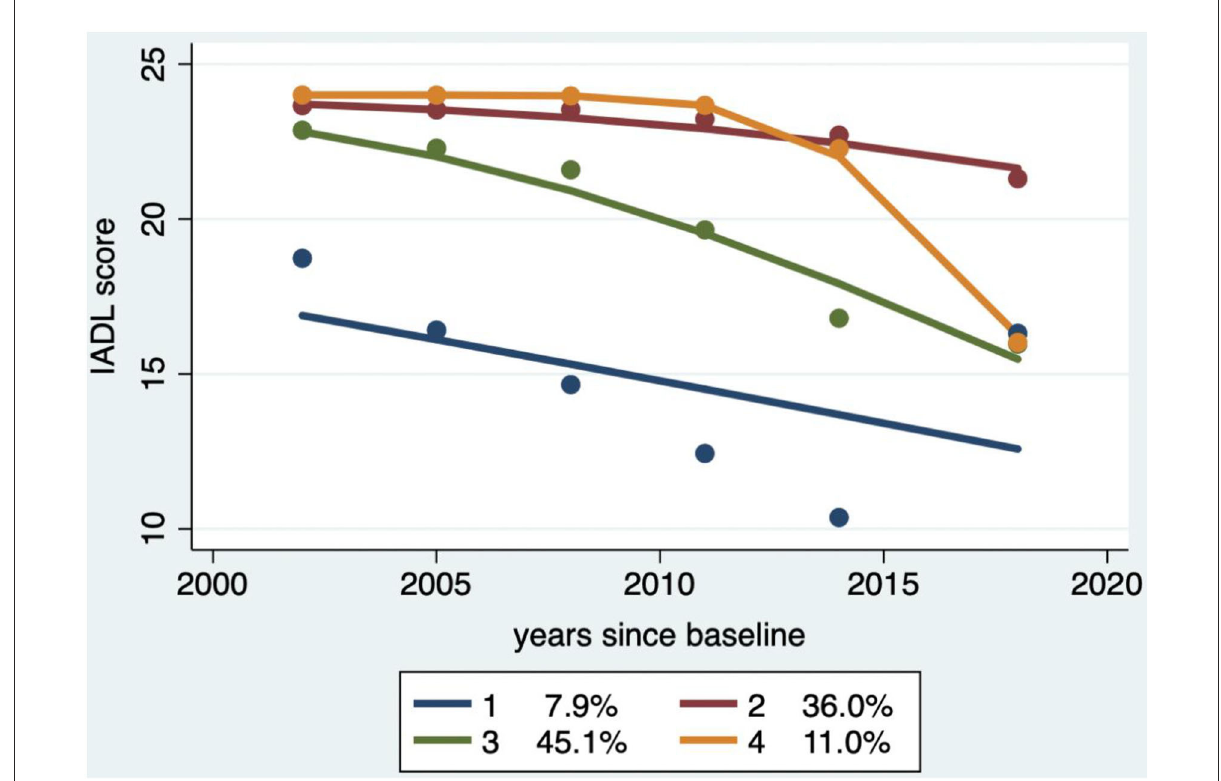
FIGUREA2 Results of physical function trajectories in 769 older